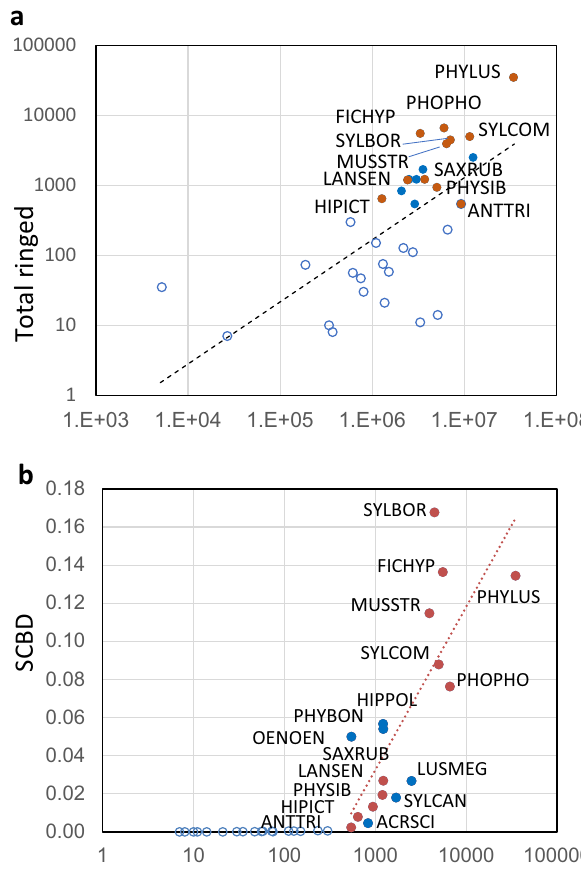
Figure 3. ( a ) Relationship between continental abundance (horizontal axis) and total number ringed (both in logarithmic scale). ( b ) Relationship between the total number ringed (horizontal axis, logarithmic scale) and their SCBD (Species Contribution to Beta Diversity). Hollow circles: species not captured on all islands. Filled circles represent species captured on all islands differentiating between species correlated (red circles) with RDA 1 (see Fig. 4) or not correlated with that axis (blue circles). Regression line in b fitted for species ringed on all islands only. Acronym identification in Supplementary Table S2. For clarity, only species acronyms for red circles are shown in